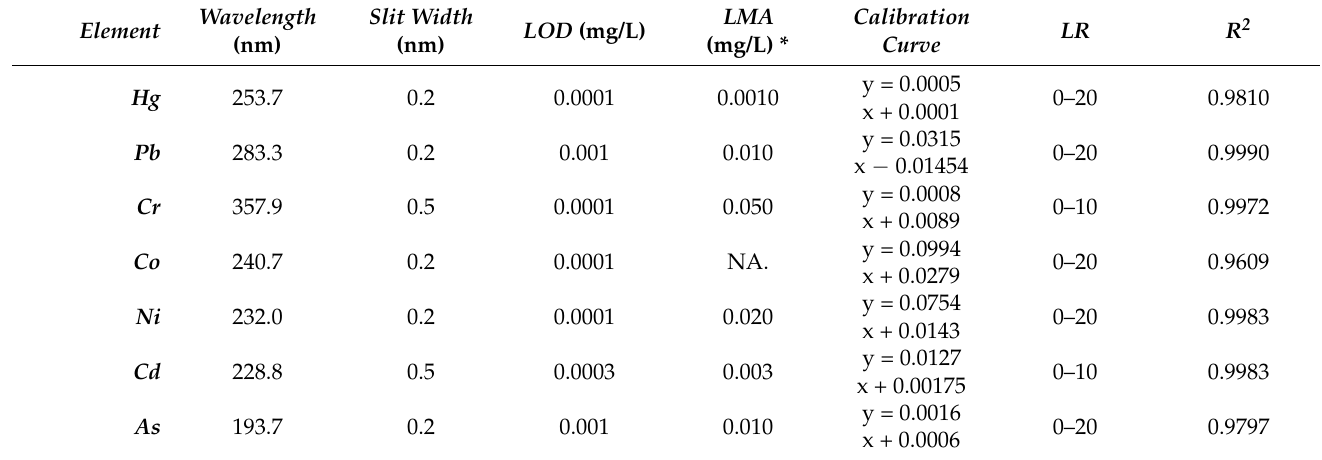
Table 4. Analytical parameters for the heavy metals screened in the present study.